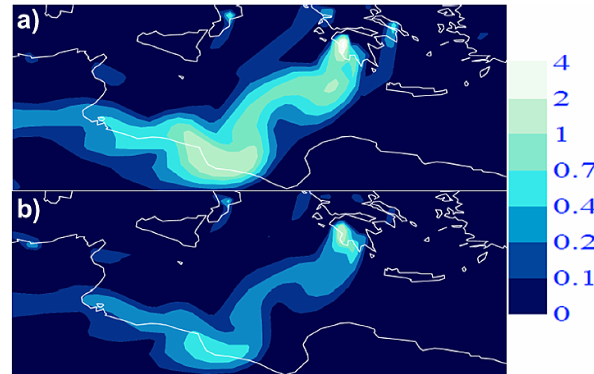
Figure 12. Modelled smoke plume on 26 August (09:35UTC) cal- culated using (a) daily, and (b) weekly temporal resolution FRP- derived smoke source emissions as described in Sect. 5.4. The blue scale indicates variations in the modelled smoke a AOD at 550nm. The corresponding modelled AOD obtained using hourly FRP-derived source emissions is shown in Fig.